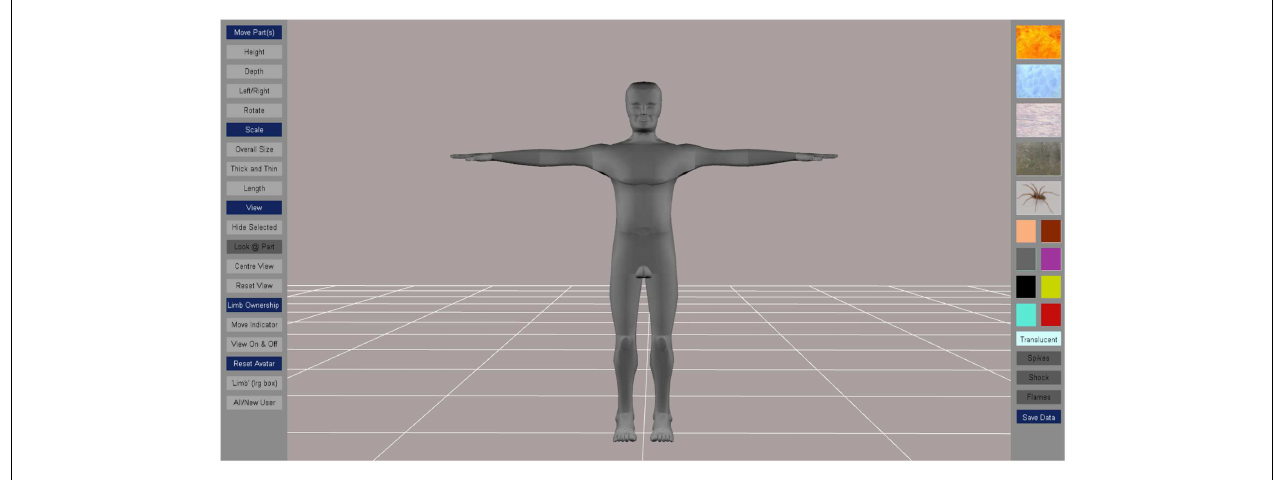
segments and changing the view are on the left hand side of the screen. Menus for colors and textures that can be applied to selected body segments are on the right hand side of the screen.